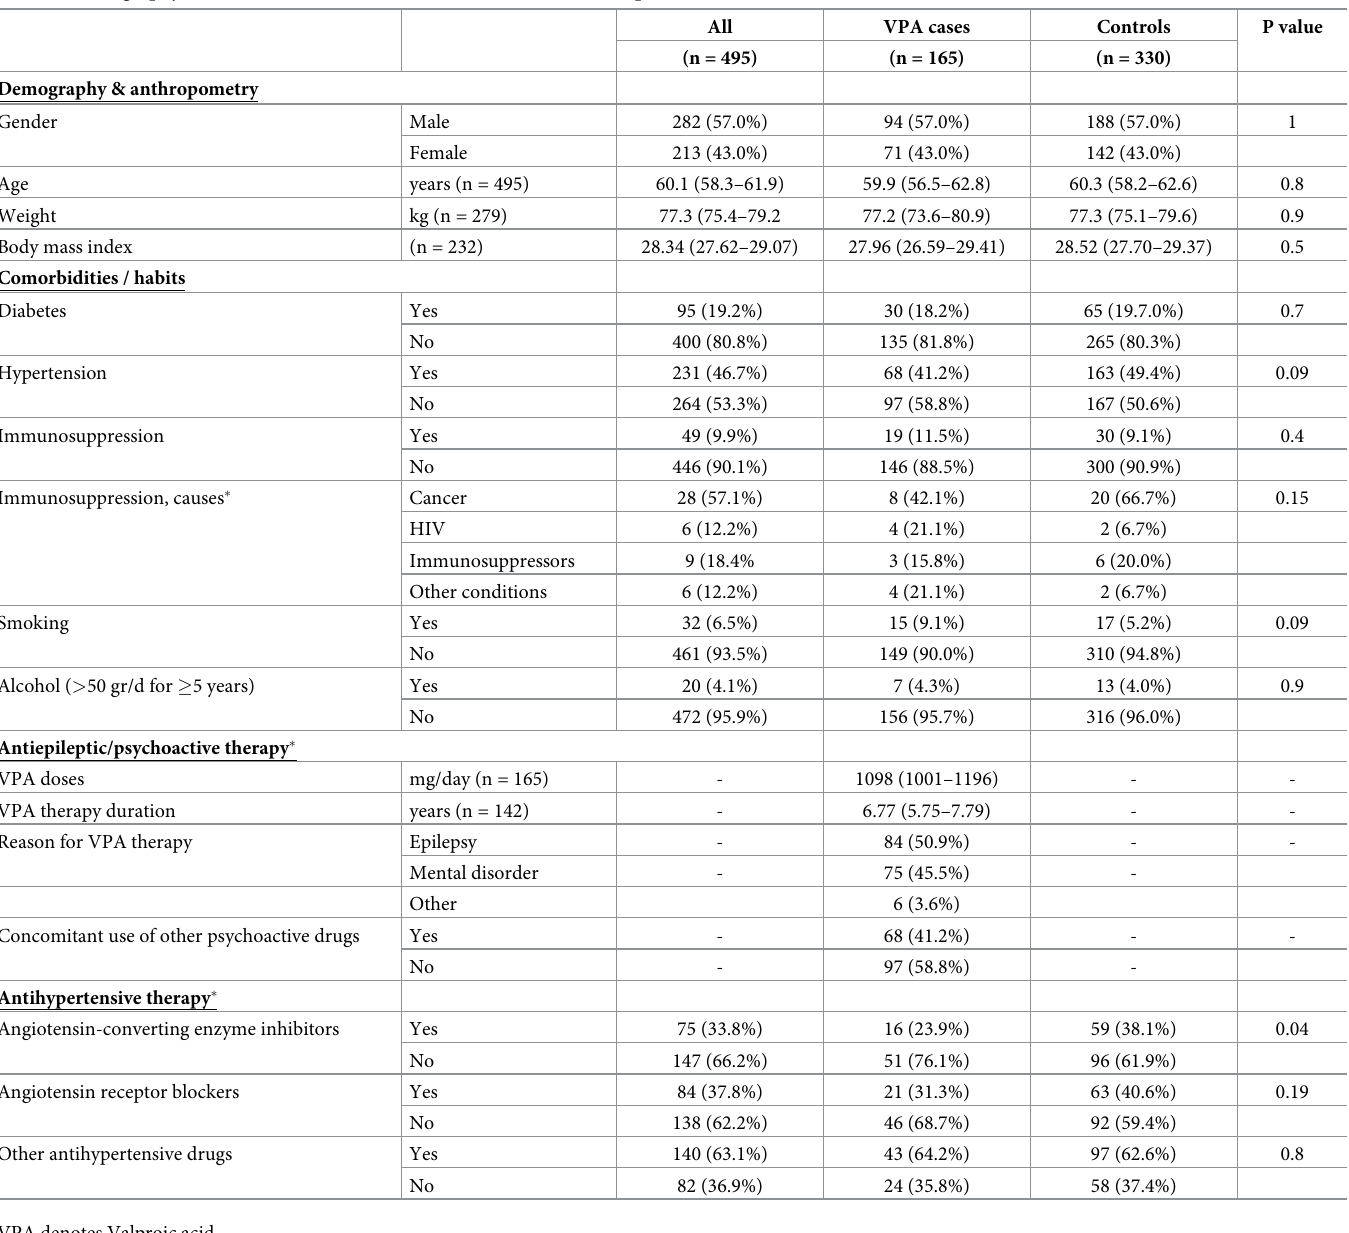
Table 1. Demography, habits, comorbidities and treatment at the time of hospital arrival.